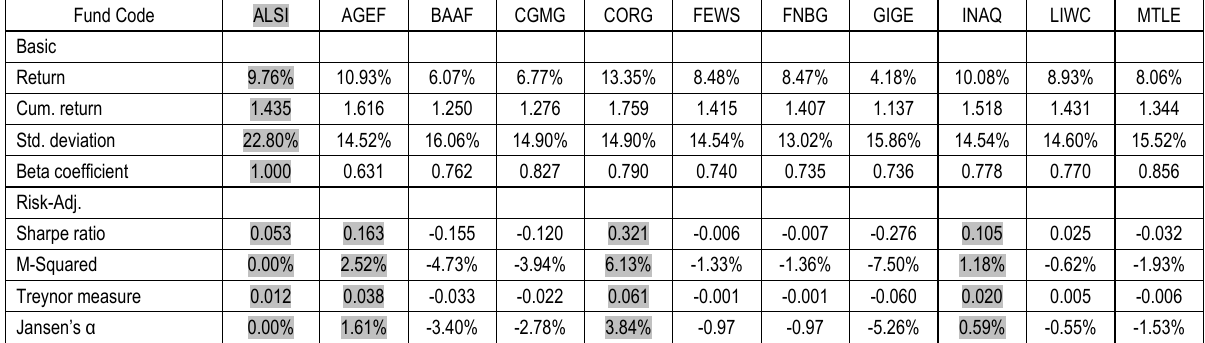
Table 2. Fund performance (Sub-period 2: 7 May 2007 to 2 Sep 2012)